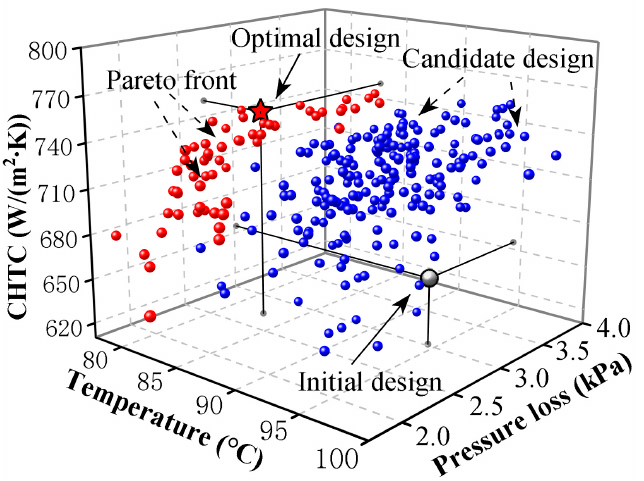
Figure 14. Pareto frontier distribution of multiple optimization targets.